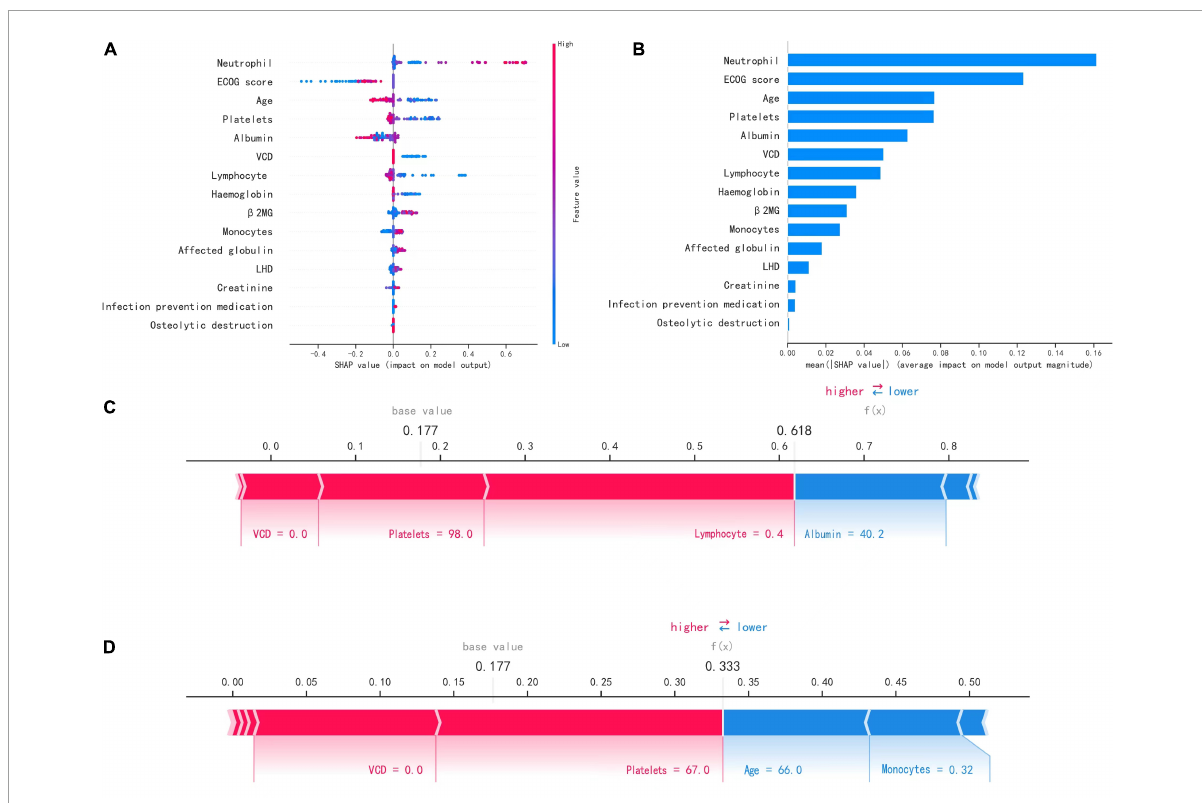
FIGURE4 Interpretation of the model. (A) SHAP plot of 15 key variables. (B) Importance ranking chart of 15 key variables. (C,D) Show patients with positive (infected) and negative (uninfected) predictions,